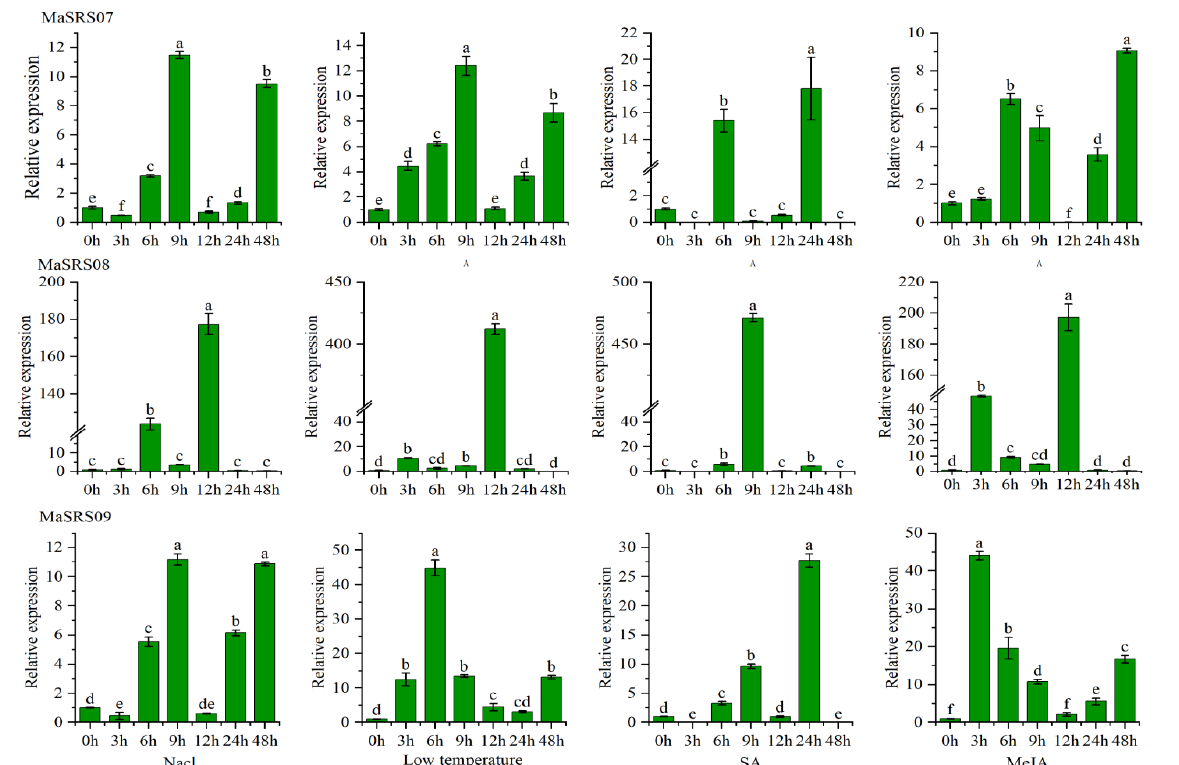
Figure 7. Expression levels of nine SRS genes in leaves of white sweet clover ( Melilotus albus ) under salinity, low temperature, salicylic acid (SA) and methyl jasmonate (MeJA) treatments. Note: data represents the means of three independent replicates ± standard deviation (SD). Small letters above the column indicate significant differences in each processing period (a = 0.05, LSD). LSD, least significant difference.